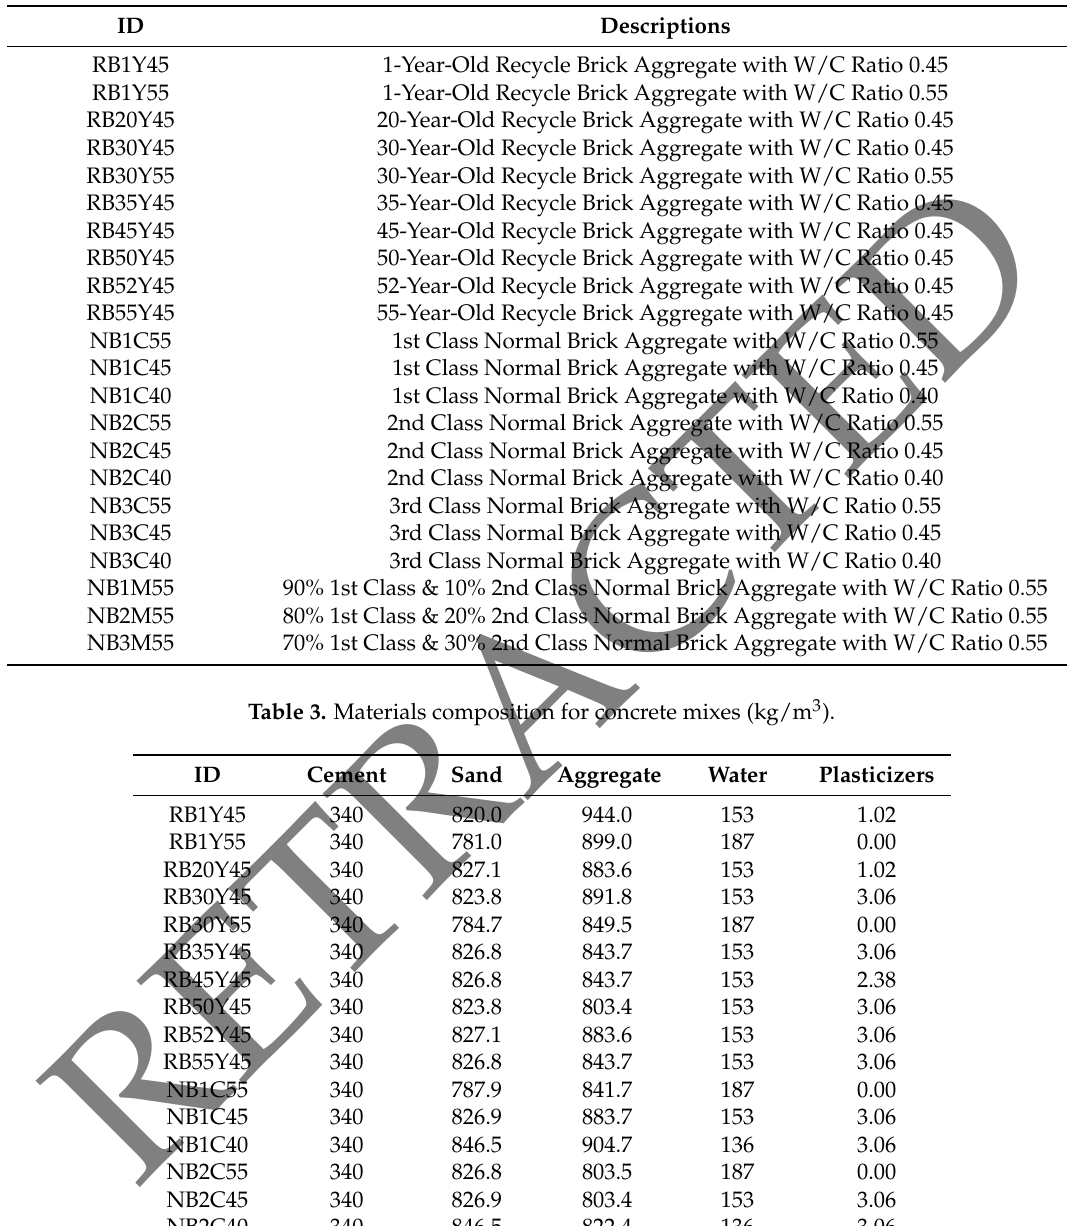
Table 2. Description of different mixes